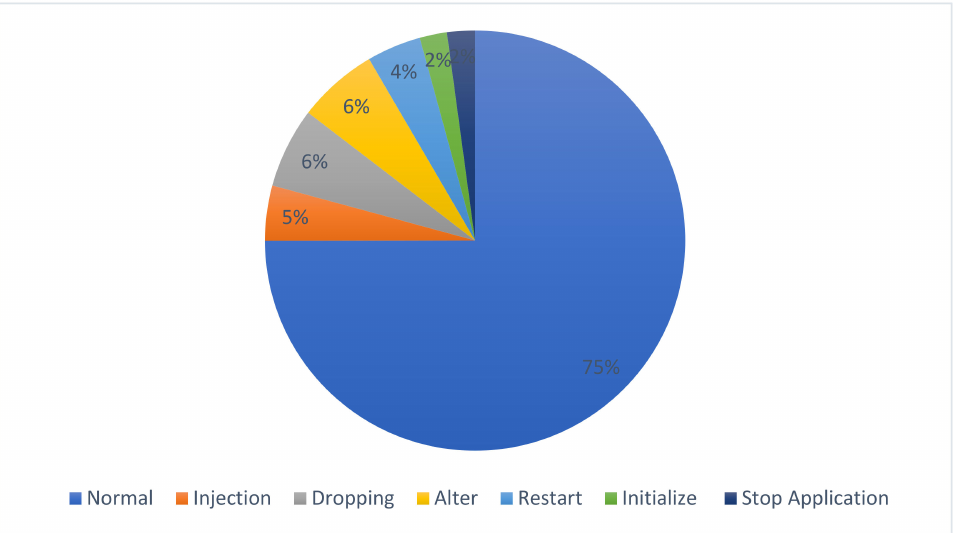
Figure 9. Function code distributions for dataset D2.